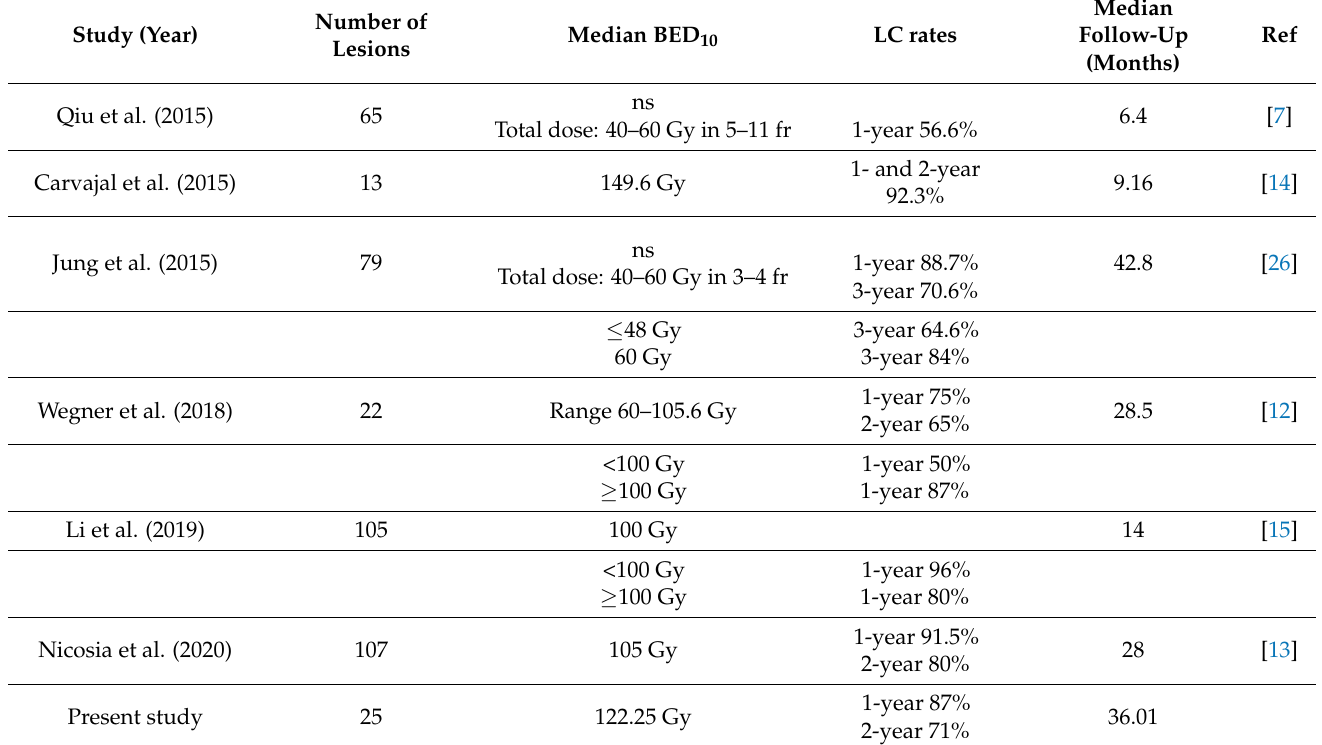
Table 3. Published reports of SBRT in patients with lung metastases from